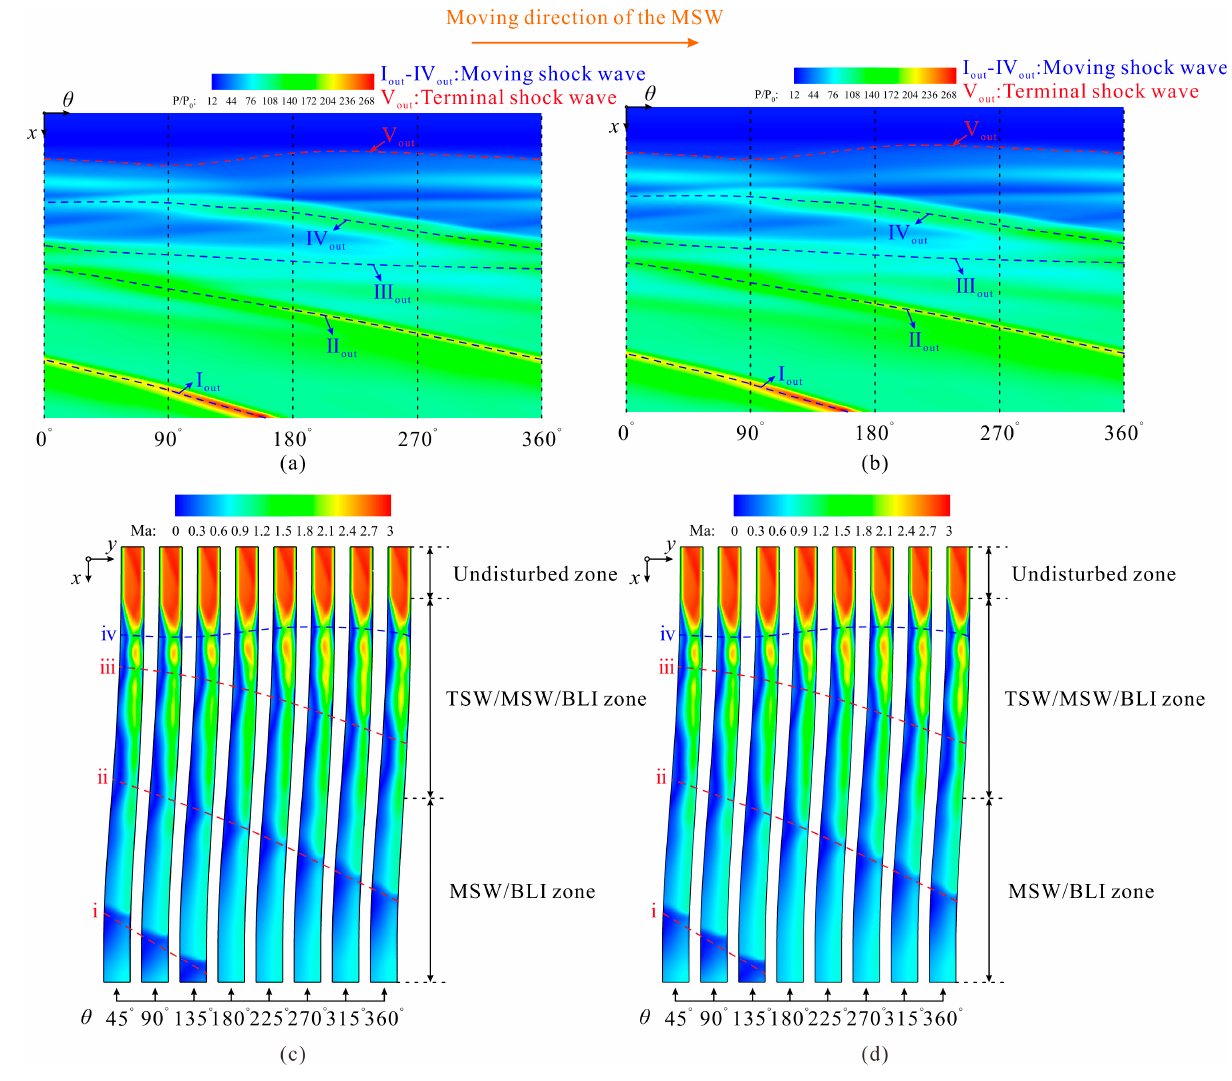
Figure 13. Critical flow structure in the adjacent cycles. ( a ) Pressure contour on the outer wall, t = n T . ( b ) Pressure contour on the outer wall, t = (n + 1) T . ( c ) Mach number contour of eight meridian planes, t = n T . ( d ) Mach number contour of eight meridian planes, t = (n + 1) T .